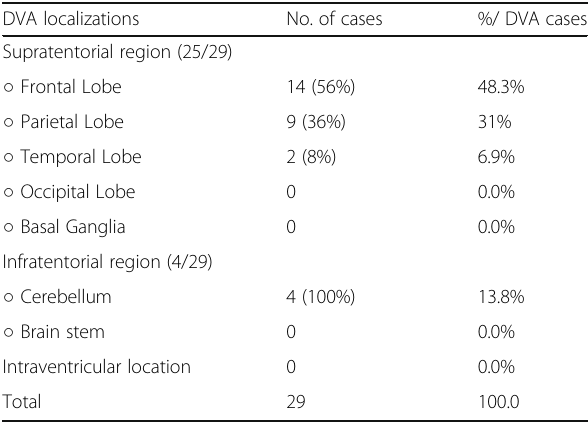
Table 2 Intracranial localizations and numerical distributions of